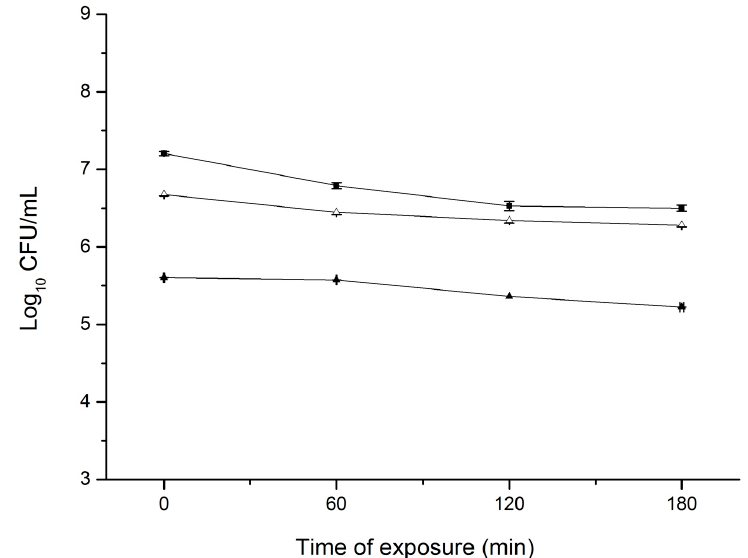
Figure 1. Survival of non ‐ habituated and cinnamon essential oil (CEO) ‐ habituated S. aureus in Luria ‐ Bertani (LB) broth containing CEO at its minimum inhibitory concentration (MIC) level (500 μ L/L). ( ■ ) non ‐ habituated cells; ( Δ ) cells pre ‐ habituated with 1/4 MIC (125 μ L/L) of CEO; ( ▲ ) cells pre ‐ habituated with 1/2 MIC (250 μ L/L) of CEO. Vertical bars represent standard deviation. Data point symbols without visible error bars signify the standard deviation smaller than the symbol size.